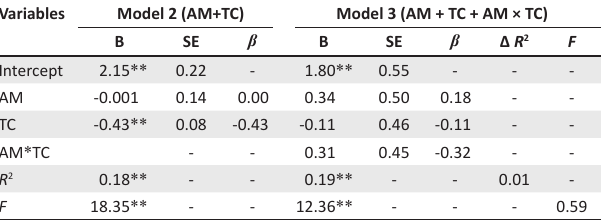
TABLE 8: Moderation effects between AM + TC + AM × TC.